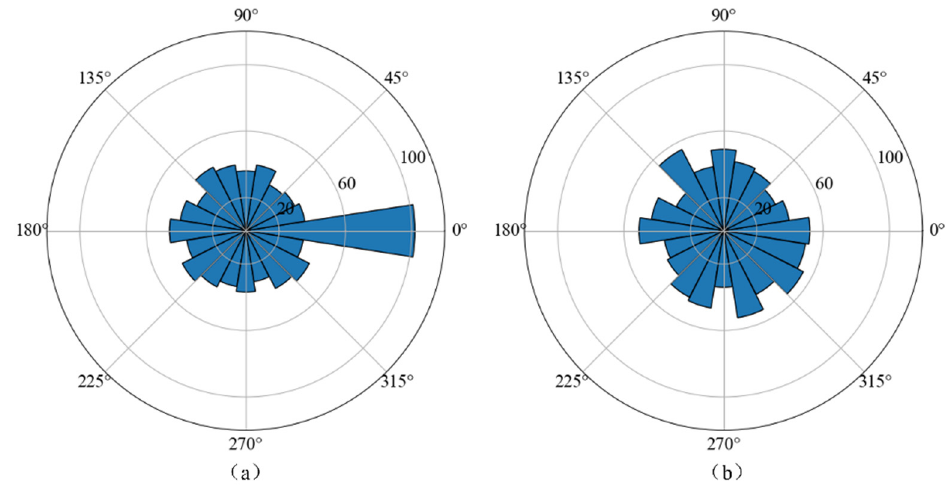
Figure 16. Histogram of path selection under specific phase conditions (a) The strongest path. (b) The sub-strong path.